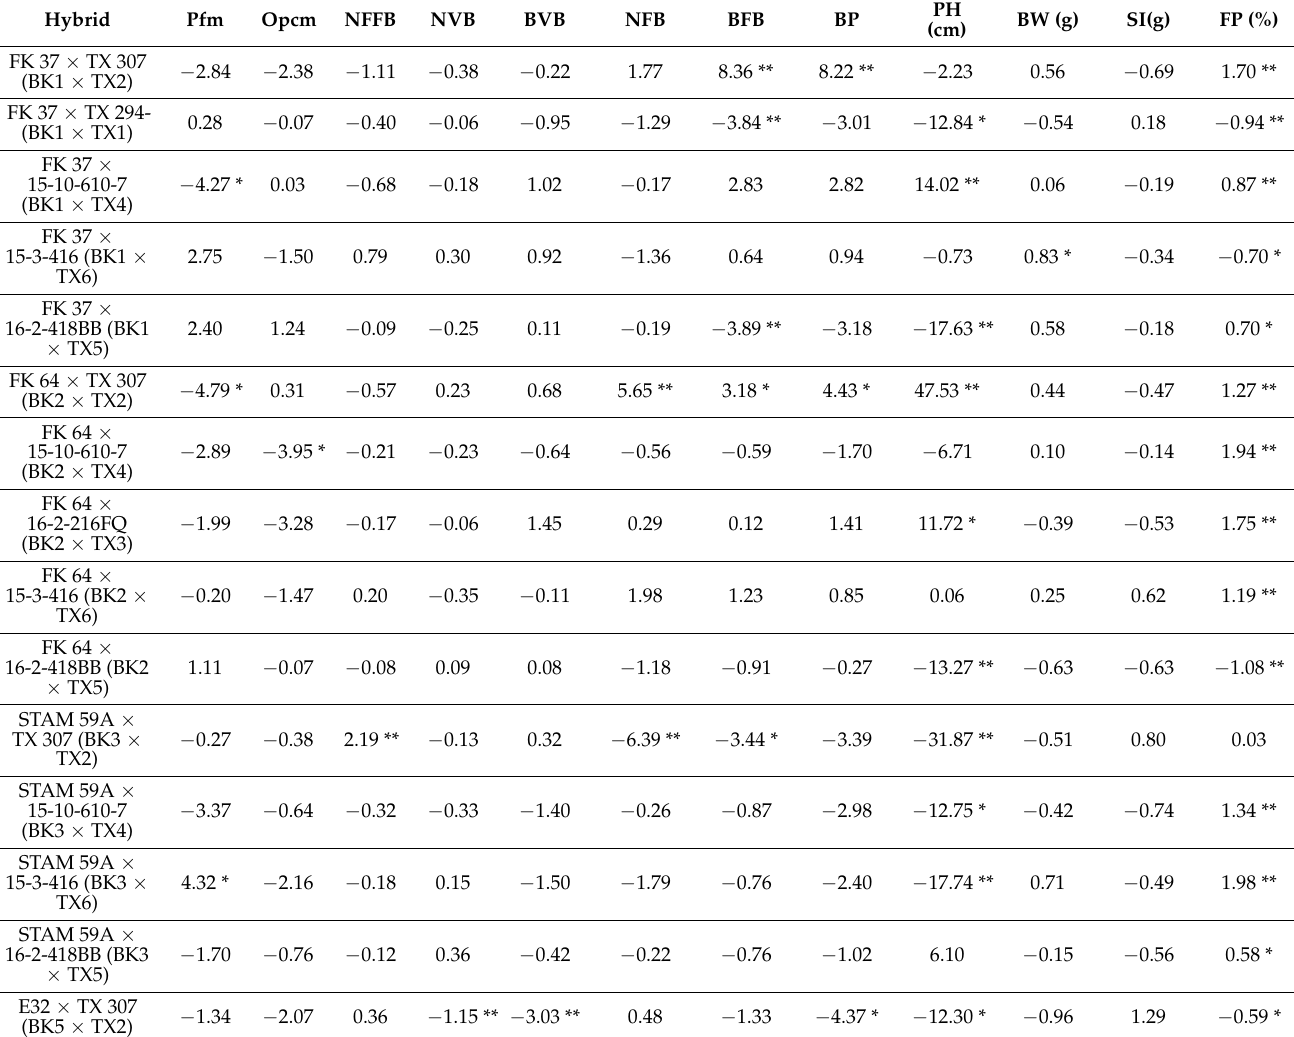
Table 4. Specific combining ability (SCA) effects for agronomic traits of 56 cotton hybrids with parental lines from Burkina Faso and the United